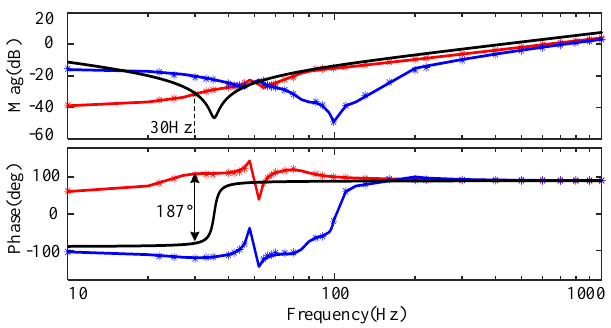
Figure 6. Model validation by frequency scanning, the lines are calculated by the impedance matrix (44), the asterisks are obtained by simulation results. Red and blue lines are positive and negative impedance, respectively. The black line is the impedance of network at 50% compensation level.